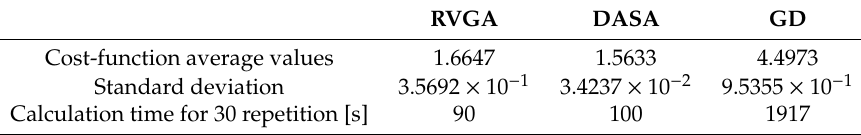
Table 9. Results of the comparison among the applied algorithms for the